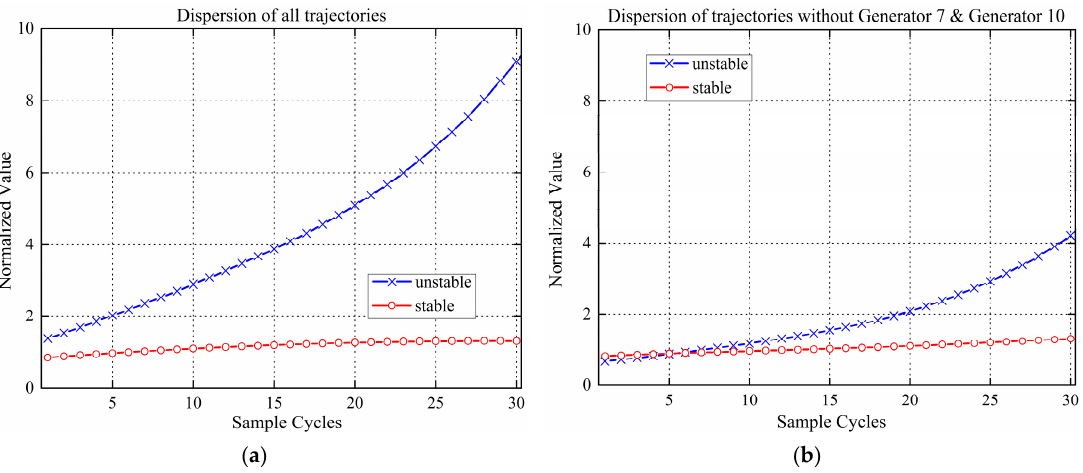
Figure 2. Variation of the trajectory dispersion, ( a ) Whole information; ( b ) Without Generator 7 and Generator 10.